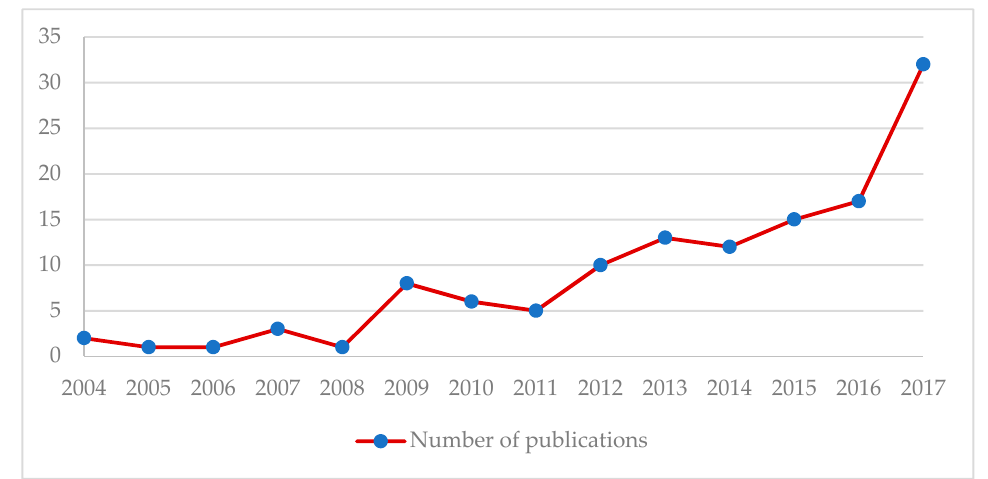
Figure 7. The publications on the topics of “multi-criteria decision making” and “sustainable energy” in the Energy Fuels Web of Science Category, 2004–2017.